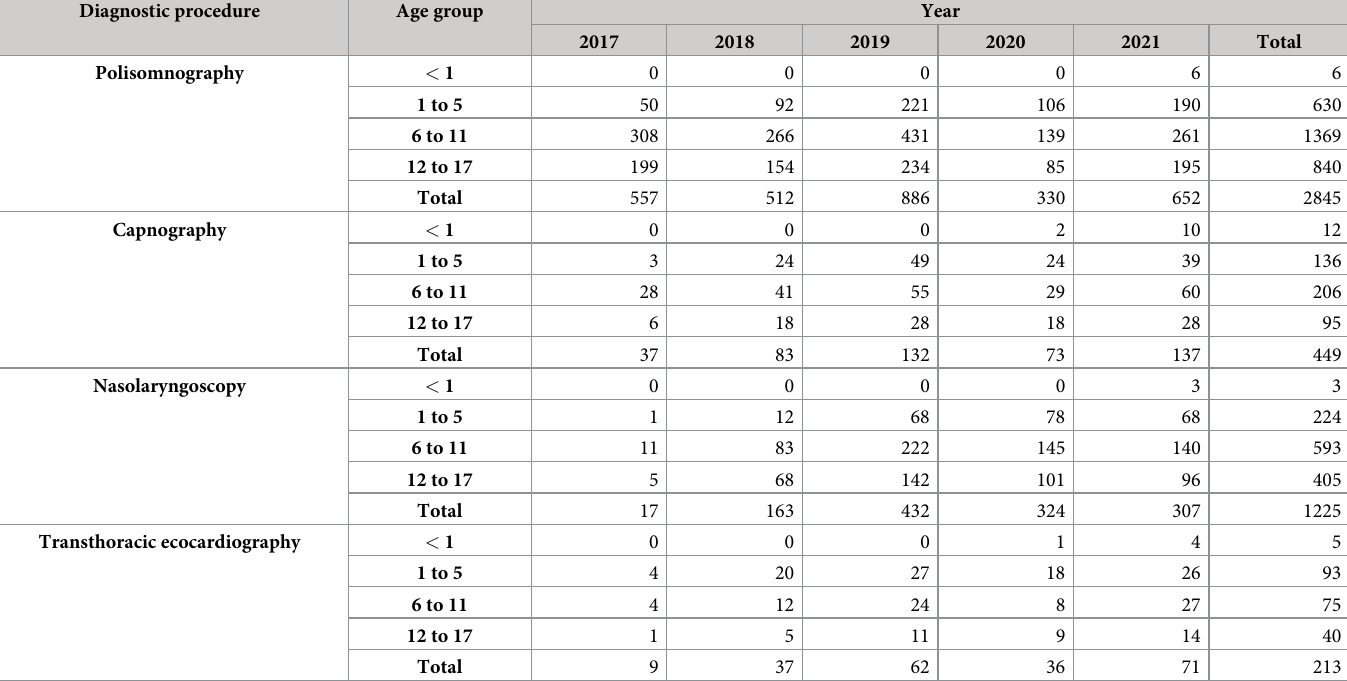
Table 4. Diagnostic procedures performed in children and adolescents with sleep apnea, Colombia 2017–2021. Diagnostic procedure